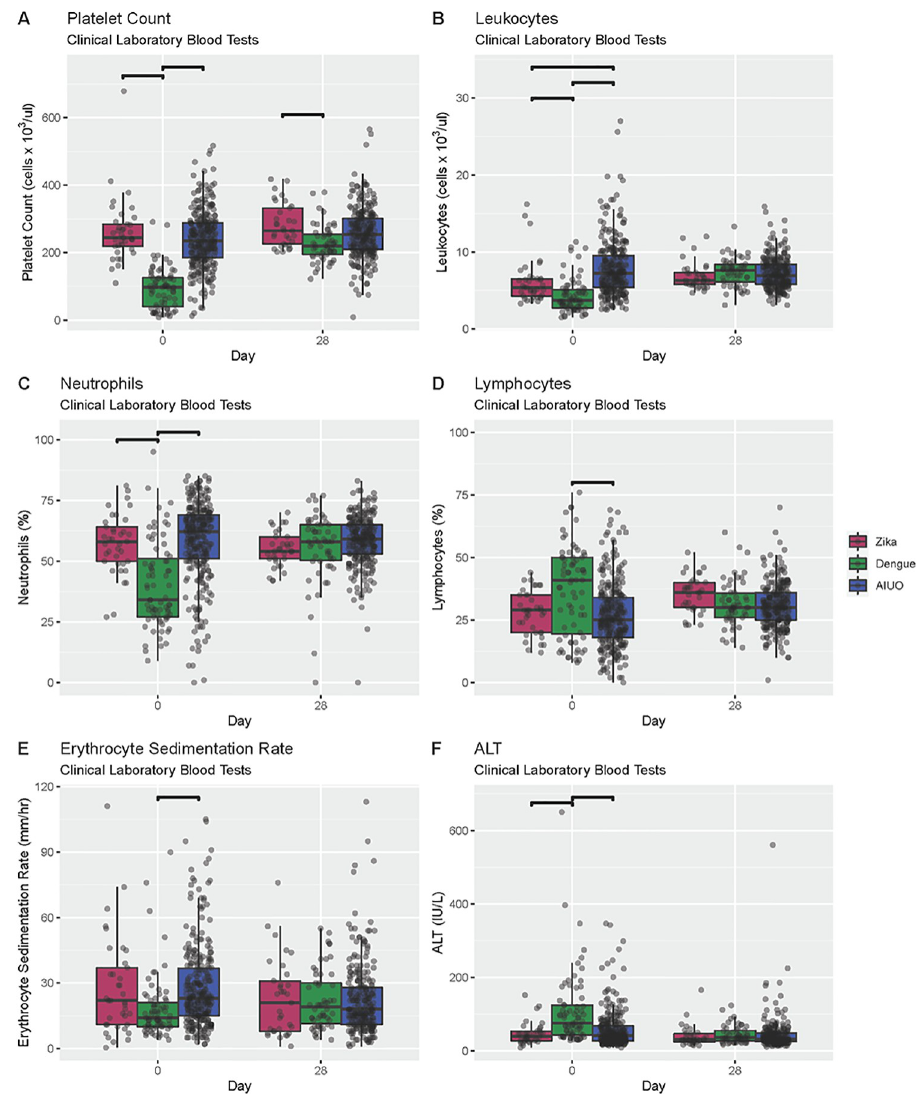
Fig 3. Comparison of clinical laboratory blood tests among patients with confirmed Zika, dengue infections, and AIUO. Darker lines above bars indicate statistically significant comparisons.